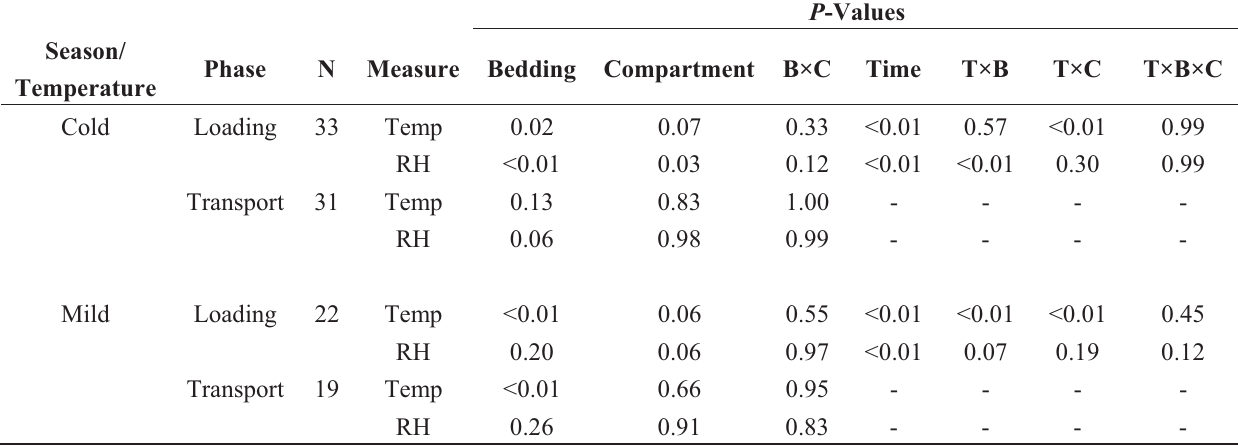
Table 2. P -values of bedding, compartment, bedding by compartment (B × C), time, time by bedding (T × B), time by compartment (T × C) and time by bedding by compartment (T × B × C) effect on temperature (Temp) and relative humidity (RH) at each phase in each